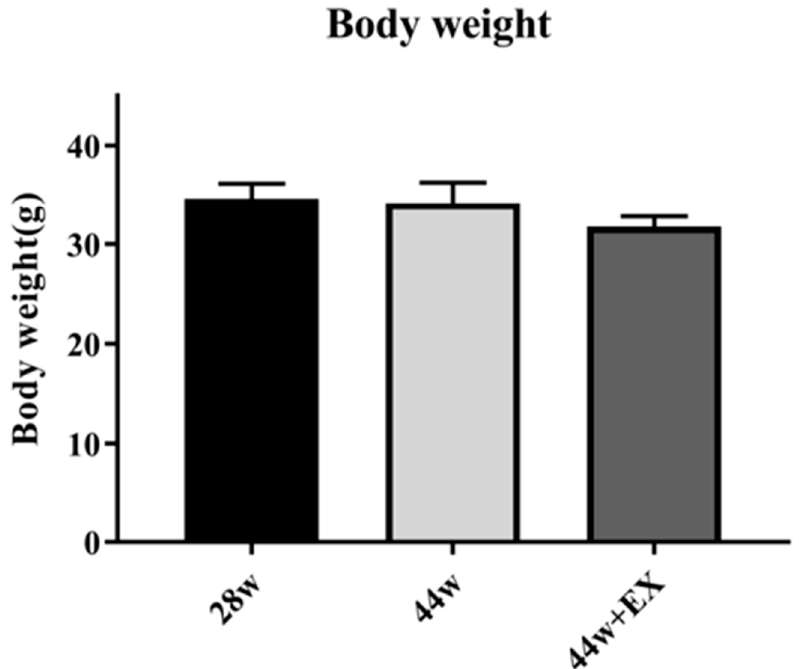
Figure 2. Body weight in each group. Body weights were measured before euthanasia at each time point. Values are means ± SE ( n =